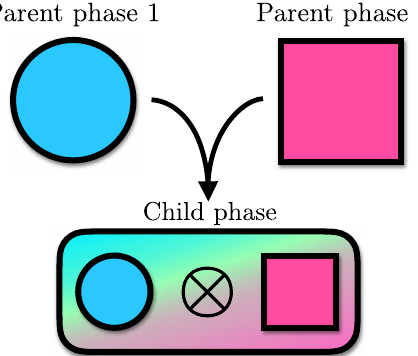
Fig. 1 Realization of multiplicative topology. Parent Hamiltonians 1 and 2, each possessing some symmetries and corresponding to a topological phase of matter, may be combined in a multiplicative manner to construct a single child Hamiltonian. This child Hamiltonian can possess an additional set of symmetries and inherit non-trivial topology from the parents in novel combinations. In this schematic, the fi rst parent is represented by a blue circle, and the second parent is represented by a red square. The child is represented by a rectangle with rounded corners, with color interpolating between the blue of parent 1 and the red of parent 2, to symbolize inheritance by the child of features of each